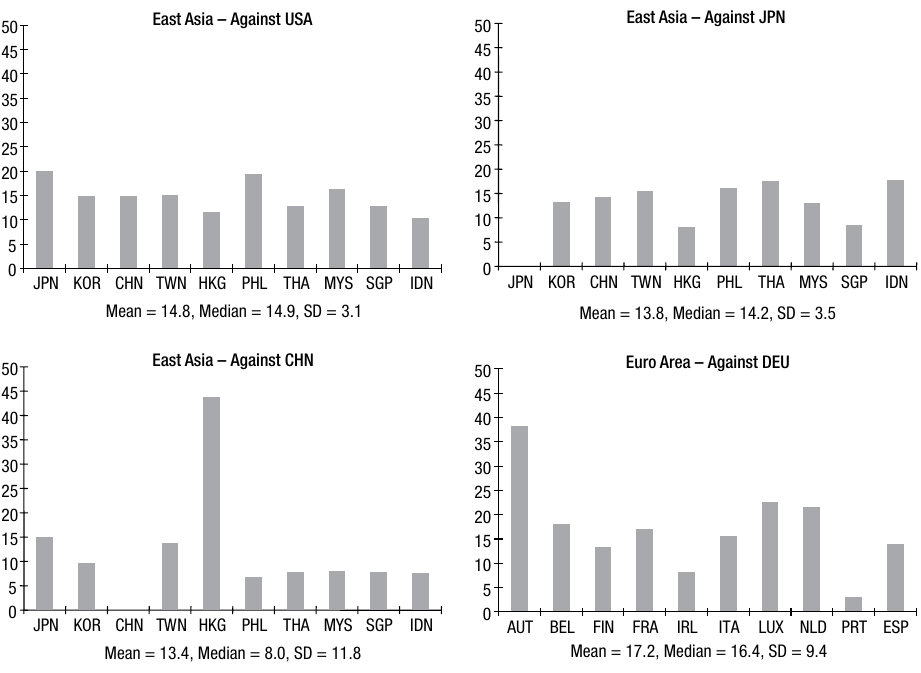
Fig. 1. Bilateral trade intensity (%), 1999–2009 Source : IMF: DOTS; Taiwan National